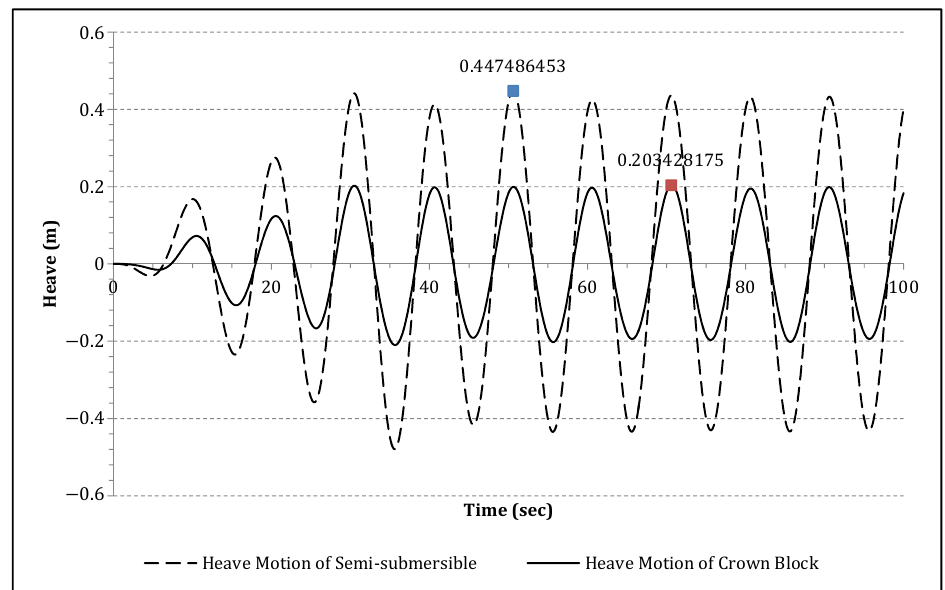
Figure 18. Heave motions of the semi-submersible and crown block for a 16.550 × 1.2-m 3 APV.